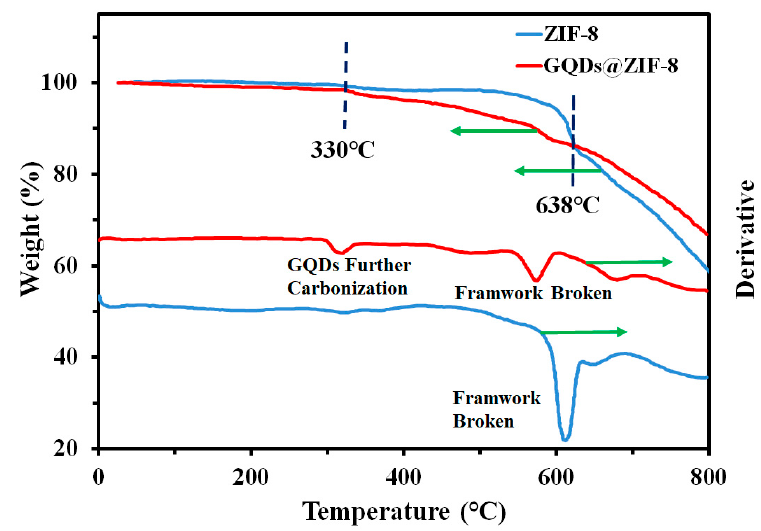
Figure 7. TG and DTG curves of ZIF-8 and GQDs@ZIF-8 composites, with the green arrows indicating the vertical coordinates corresponding to different curves.